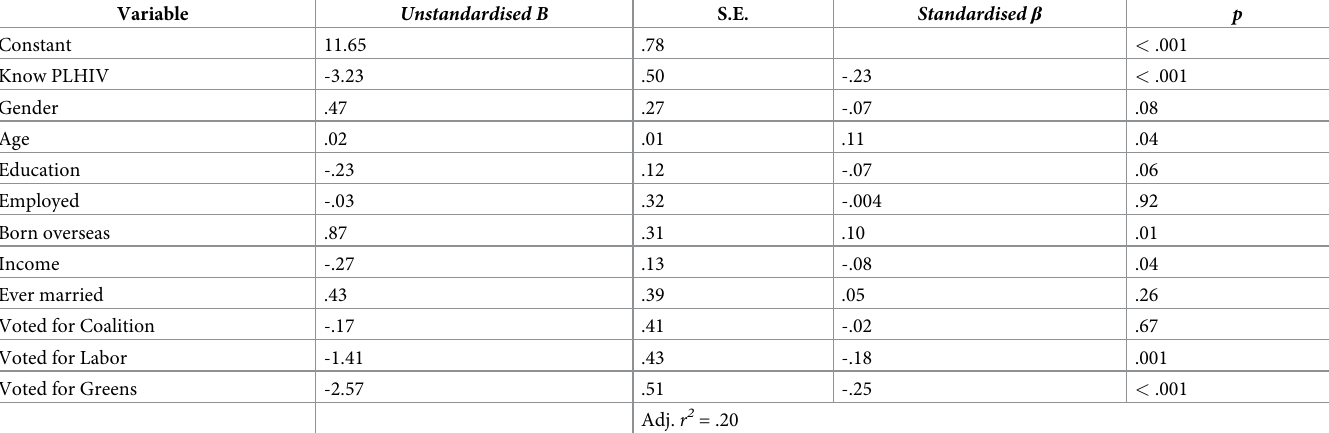
Table 4. Multiple linear regression results with people living with HIV stigma scale scores as the dependent variable.